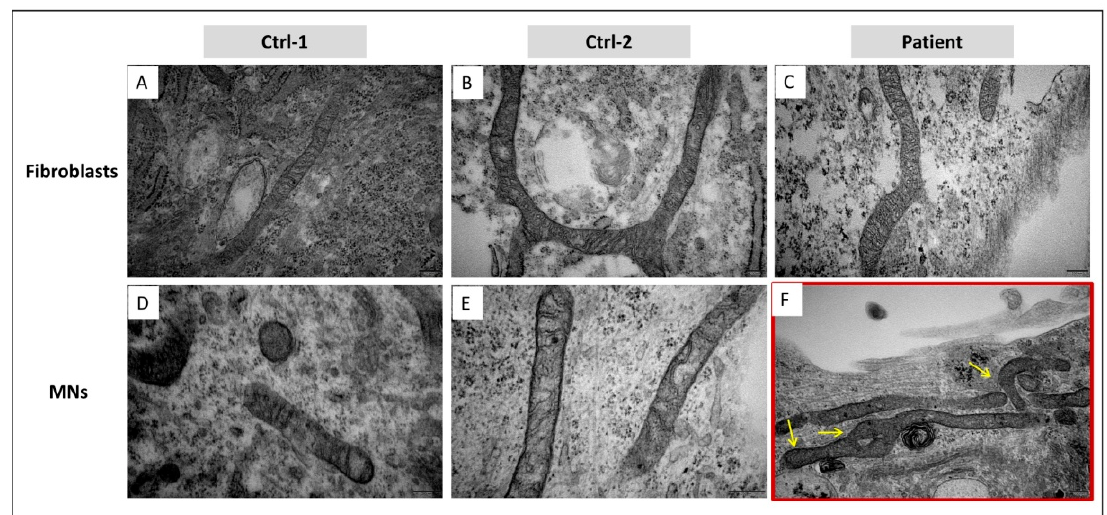
Figure 9. Ultrastructure analysis, by EM on ultrathin sections, of mitochondria in fibroblasts of Ctrl-1 ( A ), Ctrl-2 ( B ), and patient ( C ), and MNs of Ctrl-1 ( D ), Ctrl-2 ( E ), and patient ( F ). Yellow arrows point out the alteration of patient’s MNs’ mitochondrial cristae, exhibiting a perturbation of distribution and thickness. Scale bar = 200 nm in ( A – F